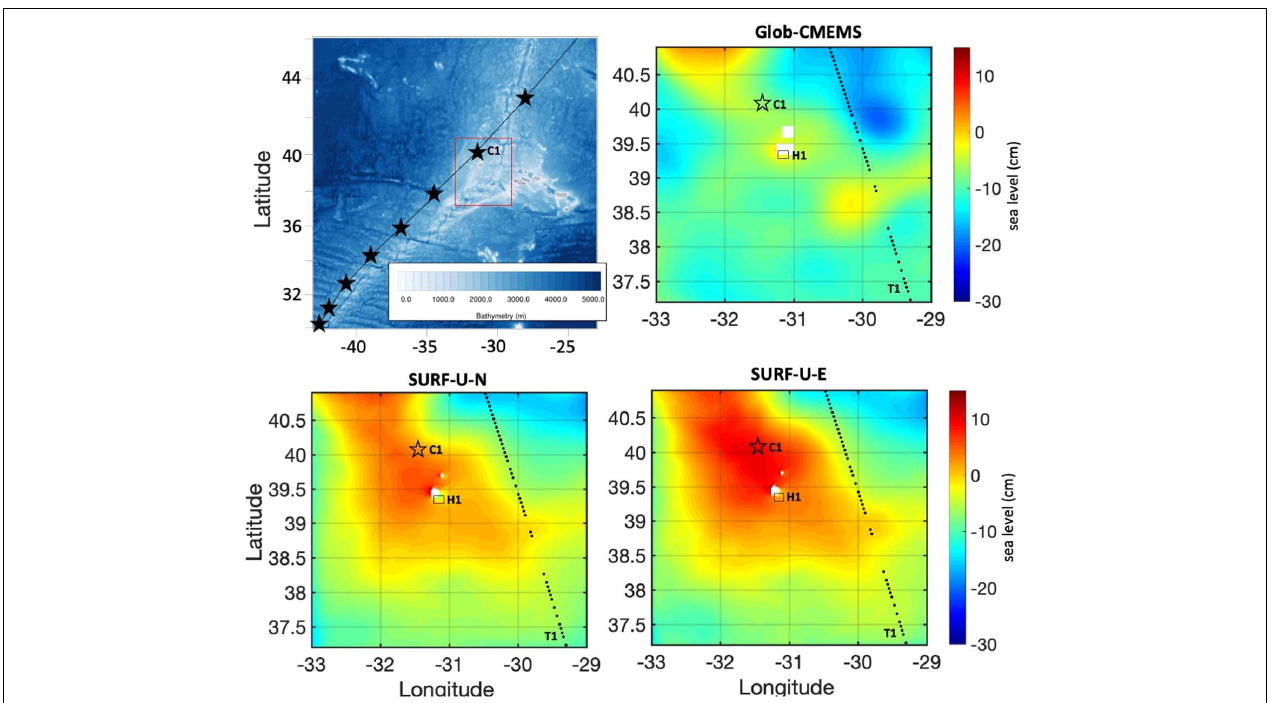
FIGURE 6 | ( Top-left panel ) Track of hurricane Lorenzo (line with stars) in the area of the Azores archipelago (red box indicates the SURF-U model); the locations of hurricane pressure minima are indicated every 6 h. Star labeled C1 is the hurricane eye on 2 October at 0600am. ( Top-right panel ) Map of sea surface height on 2 October at 0600am (C1 hurricane time) for Glob-CMEMS. Sea level for SURF-U-N ( bottom-left panel ) and SURF-U-E ( Bottom-right panel ). Altika satellite track (from SEALEVEL_GLO_PHY_L3_REP_OBSERVATIONS_008_062 CMEMS dataset) is indicated by T1. The H1 box identifies the commercial port of Lajes in Flores.